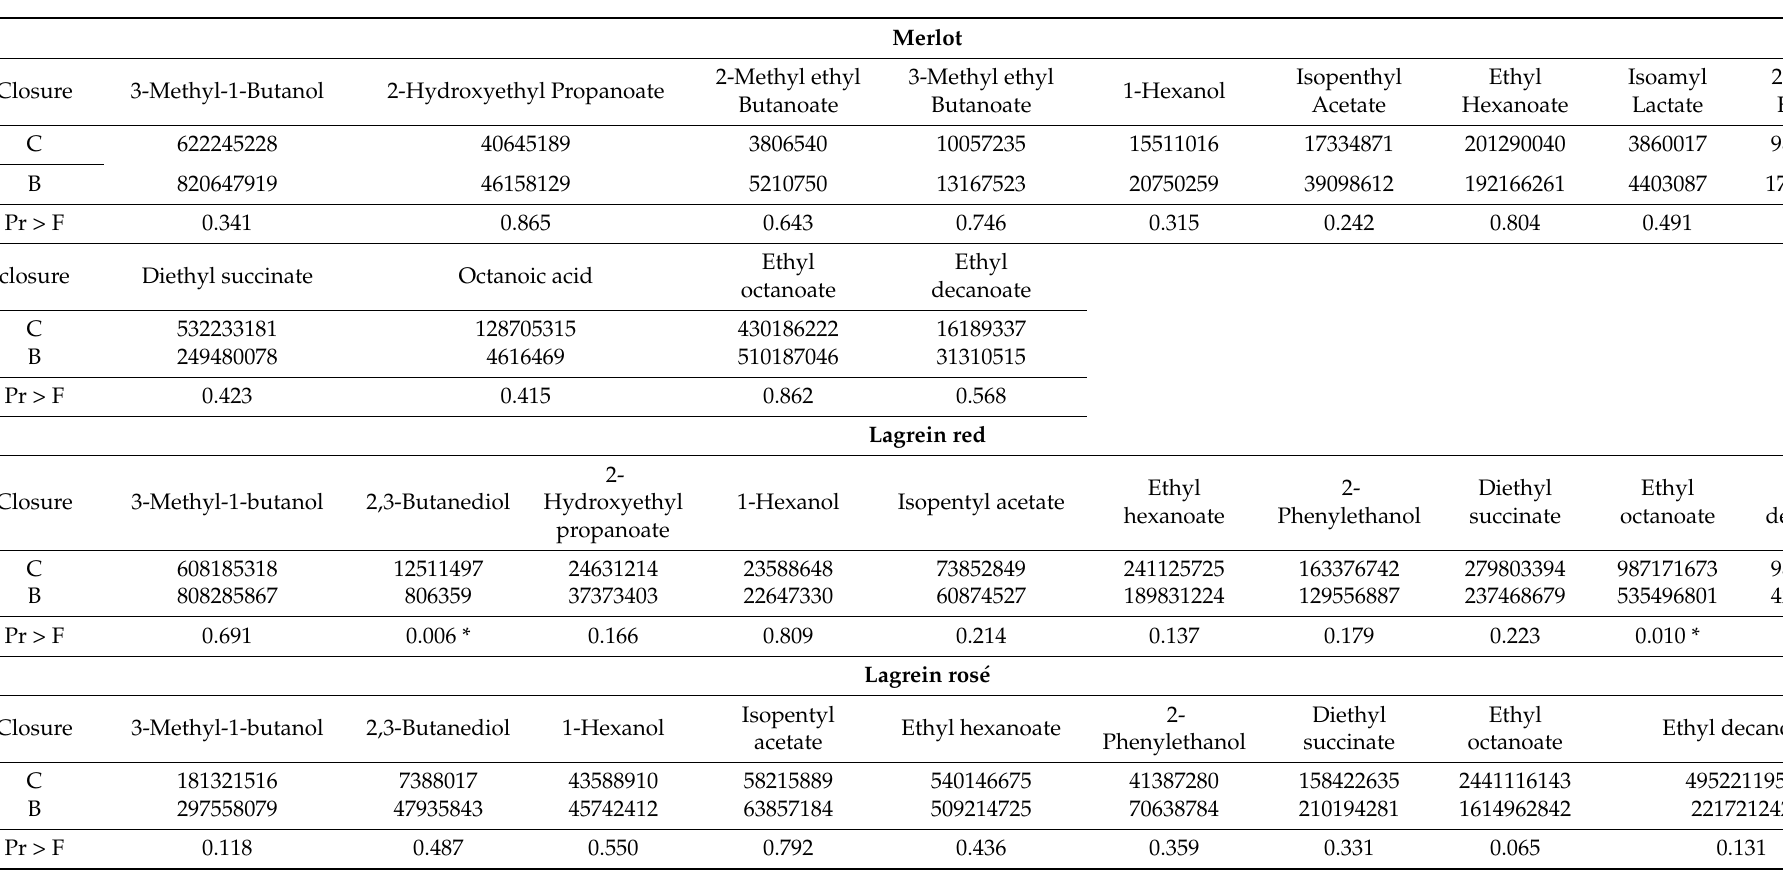
Table 3. One-way ANOVA of the volatile compounds found in each type of wine closed with ‘conventional’ and ‘blend’ closures (closure effect) at 30 months of storage. Pr > F indicates the p -value associated with the F statistic. The asterisk (*) means significantly different using Tukey’s test ( α < 0.05). B and C, blend and conventional closure,